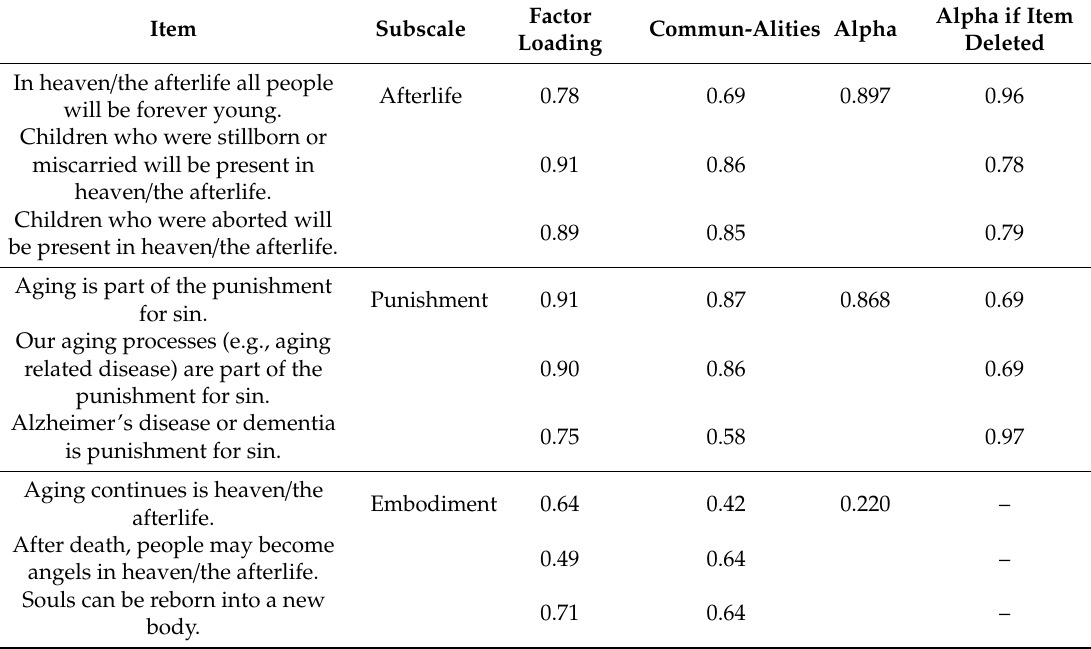
Table 4. Religious-based beliefs about aging subscales ( n =